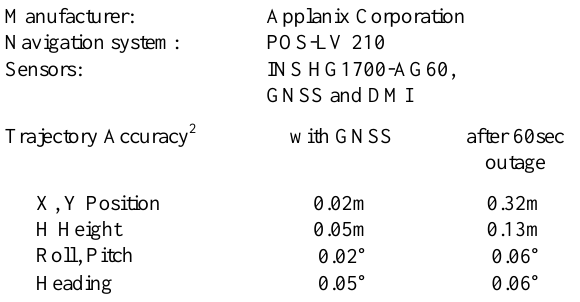
Table 1. Direct vs. integrated georeferencing accuracy – residual coordinate differences in control and check